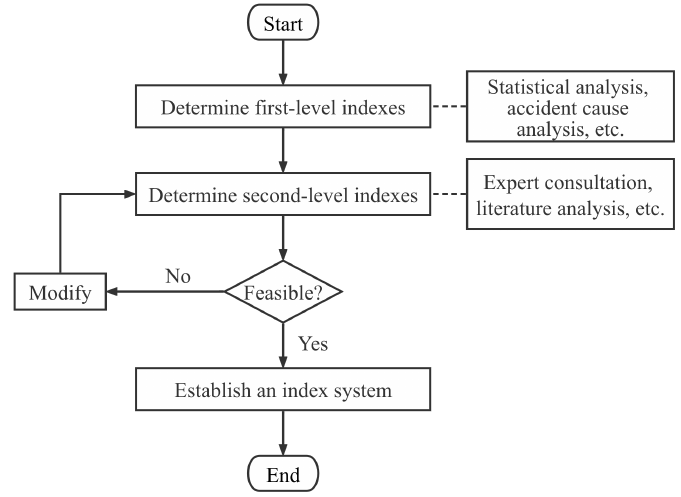
Figure 1. Index determination